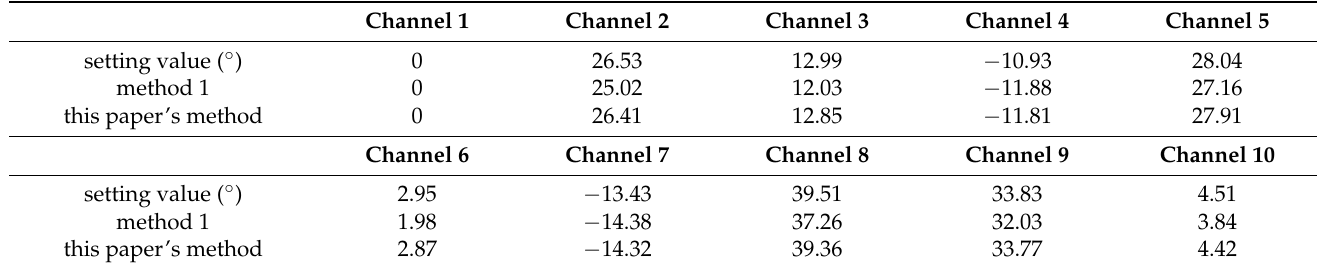
Table 5. Phase bias estimation of multiple-channels